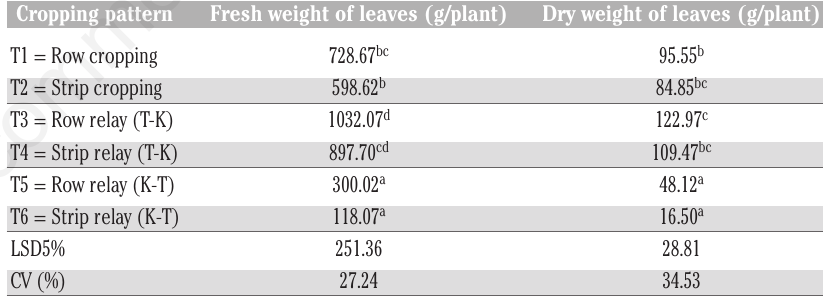
Table 2. Fresh and dry weight of curcuma leaves on various cropping patterns. Cropping pattern